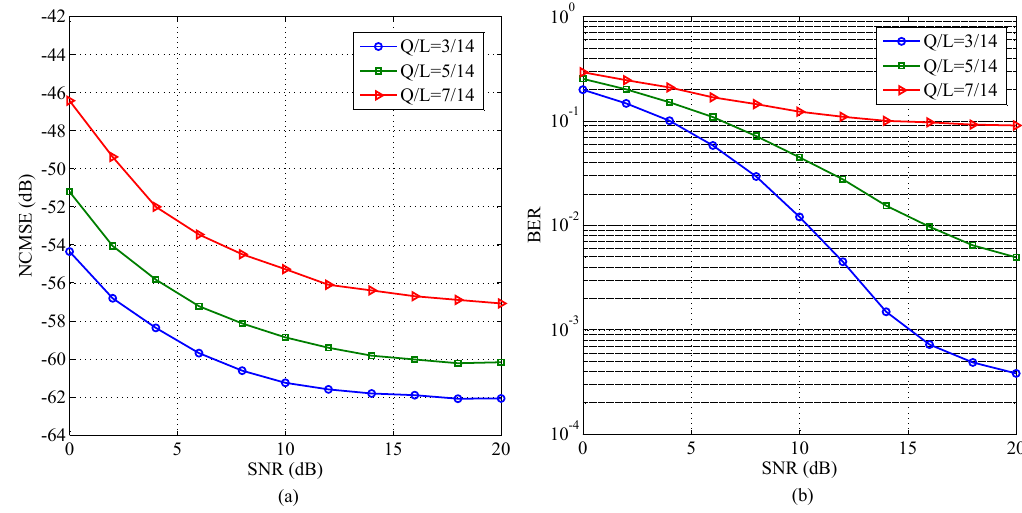
Figure 3. Effect of channel sparsity variation on superimposed training stagewise orthogonal matching pursuit (SiT-StOMP), M = 1500 bits, and σ 2 c based performance.